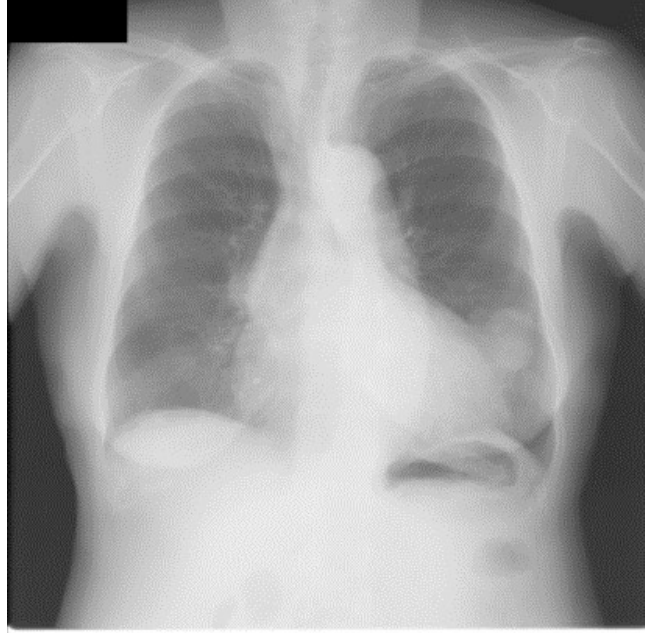
Figure 7. An image from Japanese Society of Radiological Technology (JSRT) database.